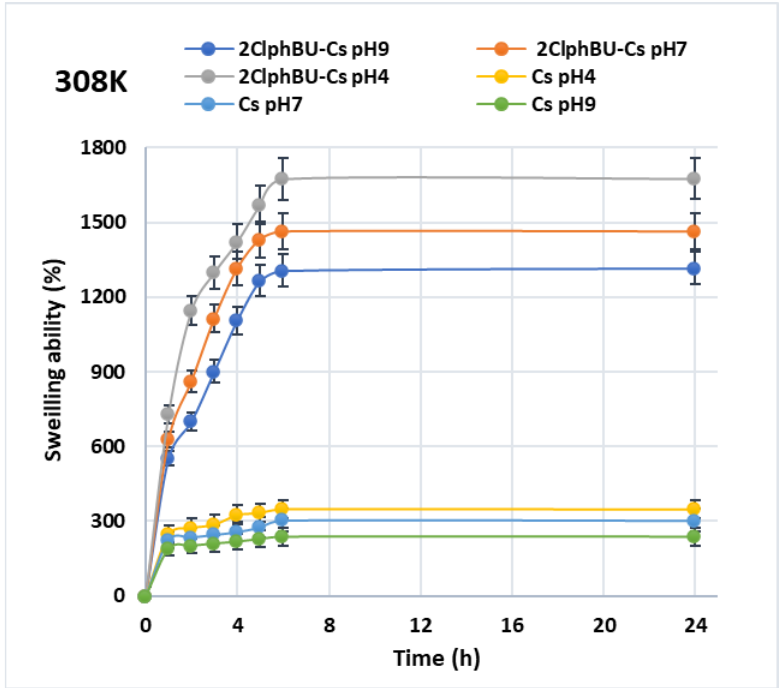
Figure 8. Swelling ability of Cs and 2Clph-BU-Cs hydrogel in pH 4, 7, and 9 at T= 308 K.